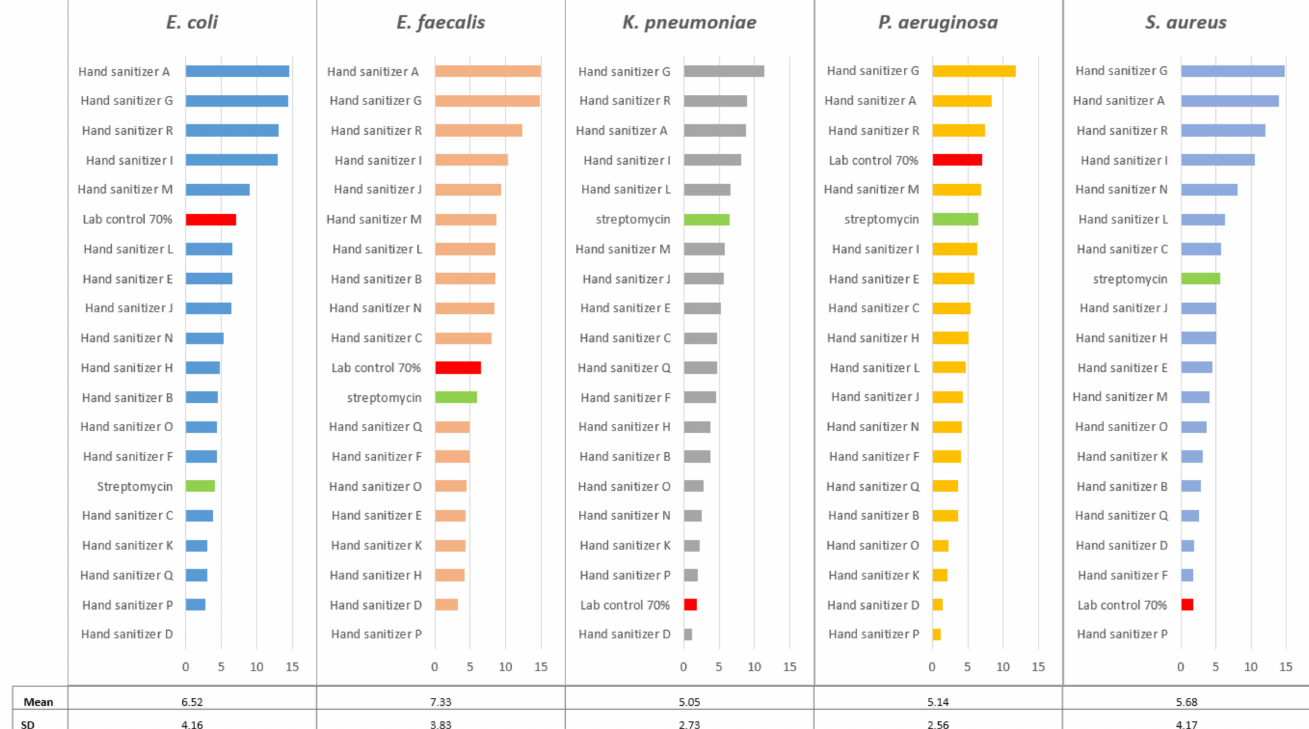
Figure 1. Zones of inhibition (mm) of the bacterial strains against hand sanitizers (A–R). The positive control is reflected by the green highlight, and the zone of inhibition lower than the positive control is shown by the red